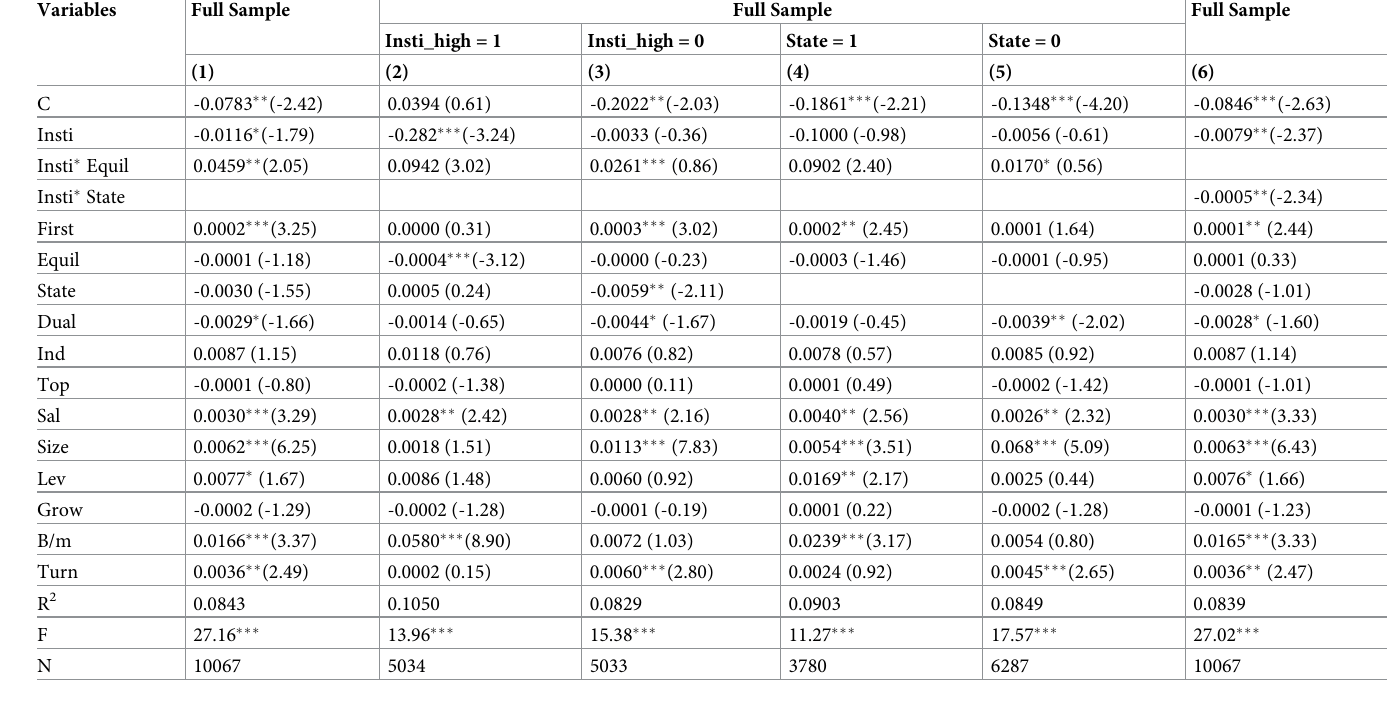
Table 4. The effect on the cost of capital of ownership structure and institutional